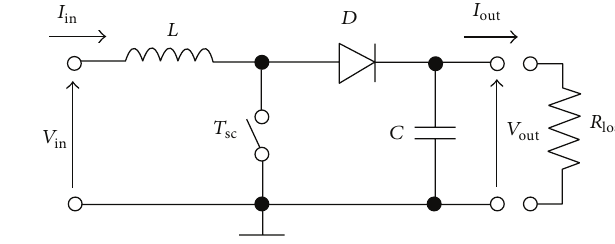
Figure 10: Sketch of the ideal Boost-converter